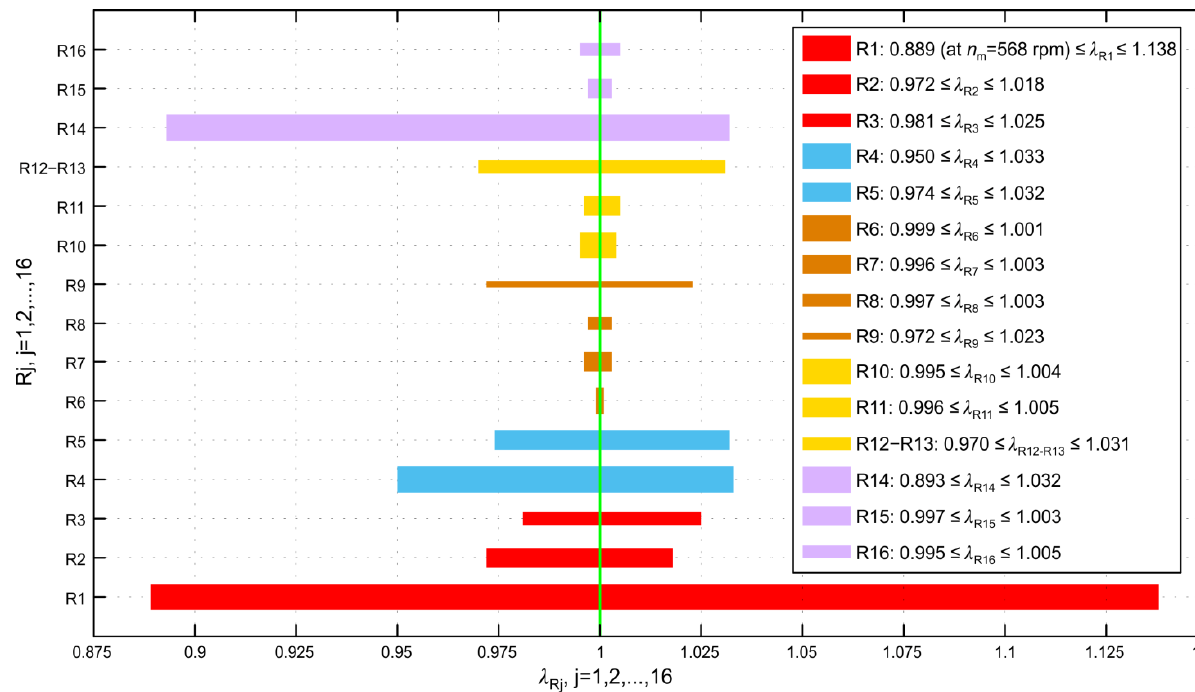
Figure 22. Resonant frequency ratios within the span of 600 rpm ≤ n m ≤ 1000 rpm.